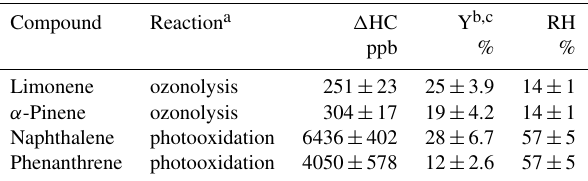
Table 1. Flow tube experimental conditions.